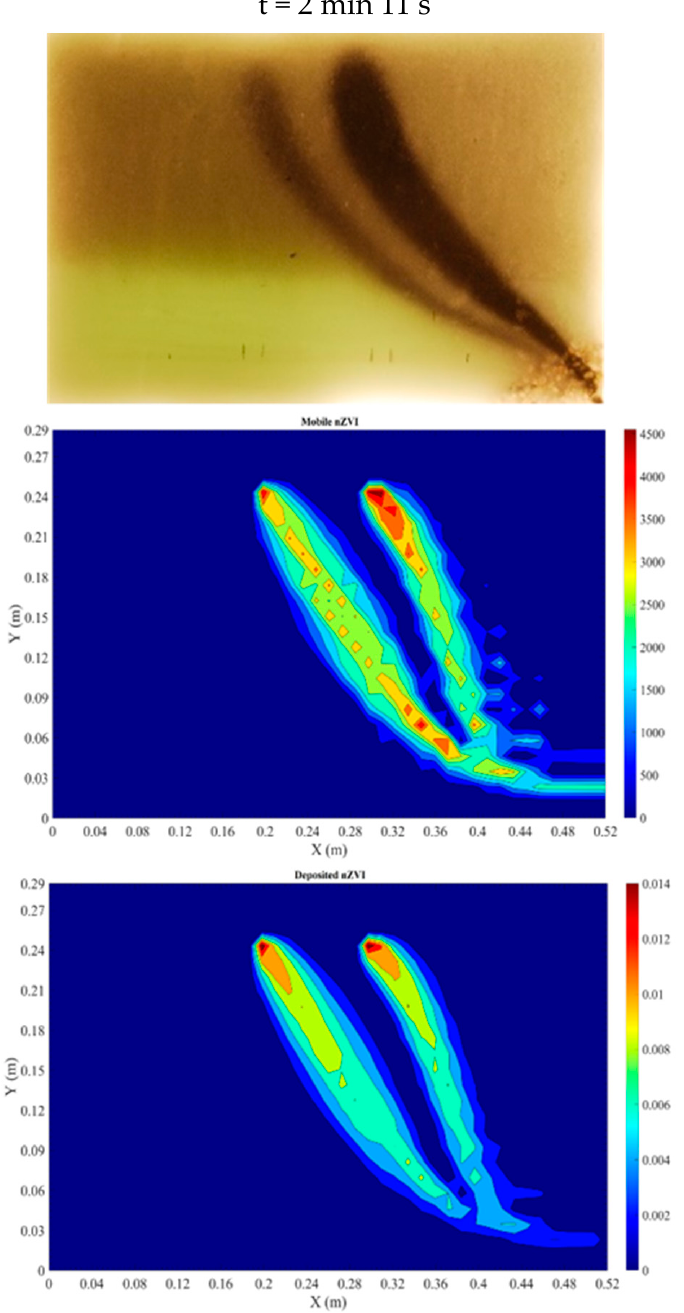
Figure 4. Results by numerical model simulations at 2 min 11 s (at the end of the injection time) .